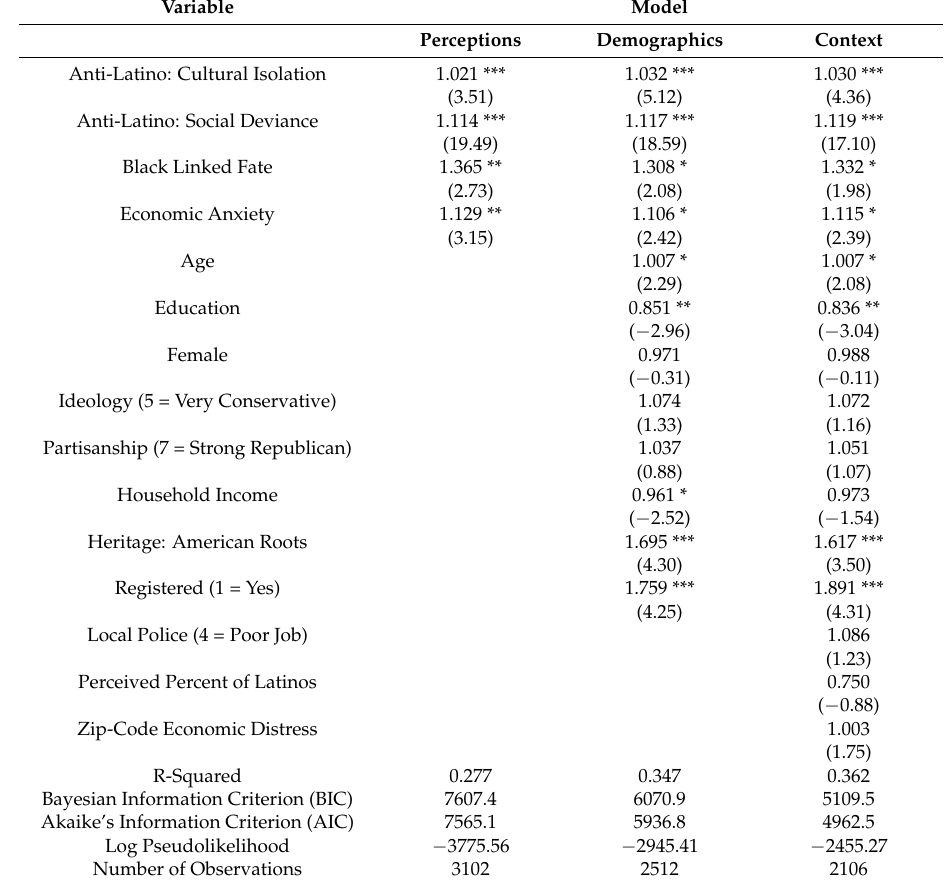
Table 4. Odds ratios from the ordinal logistic models of agreement that immigrants take jobs, housing and healthcare from